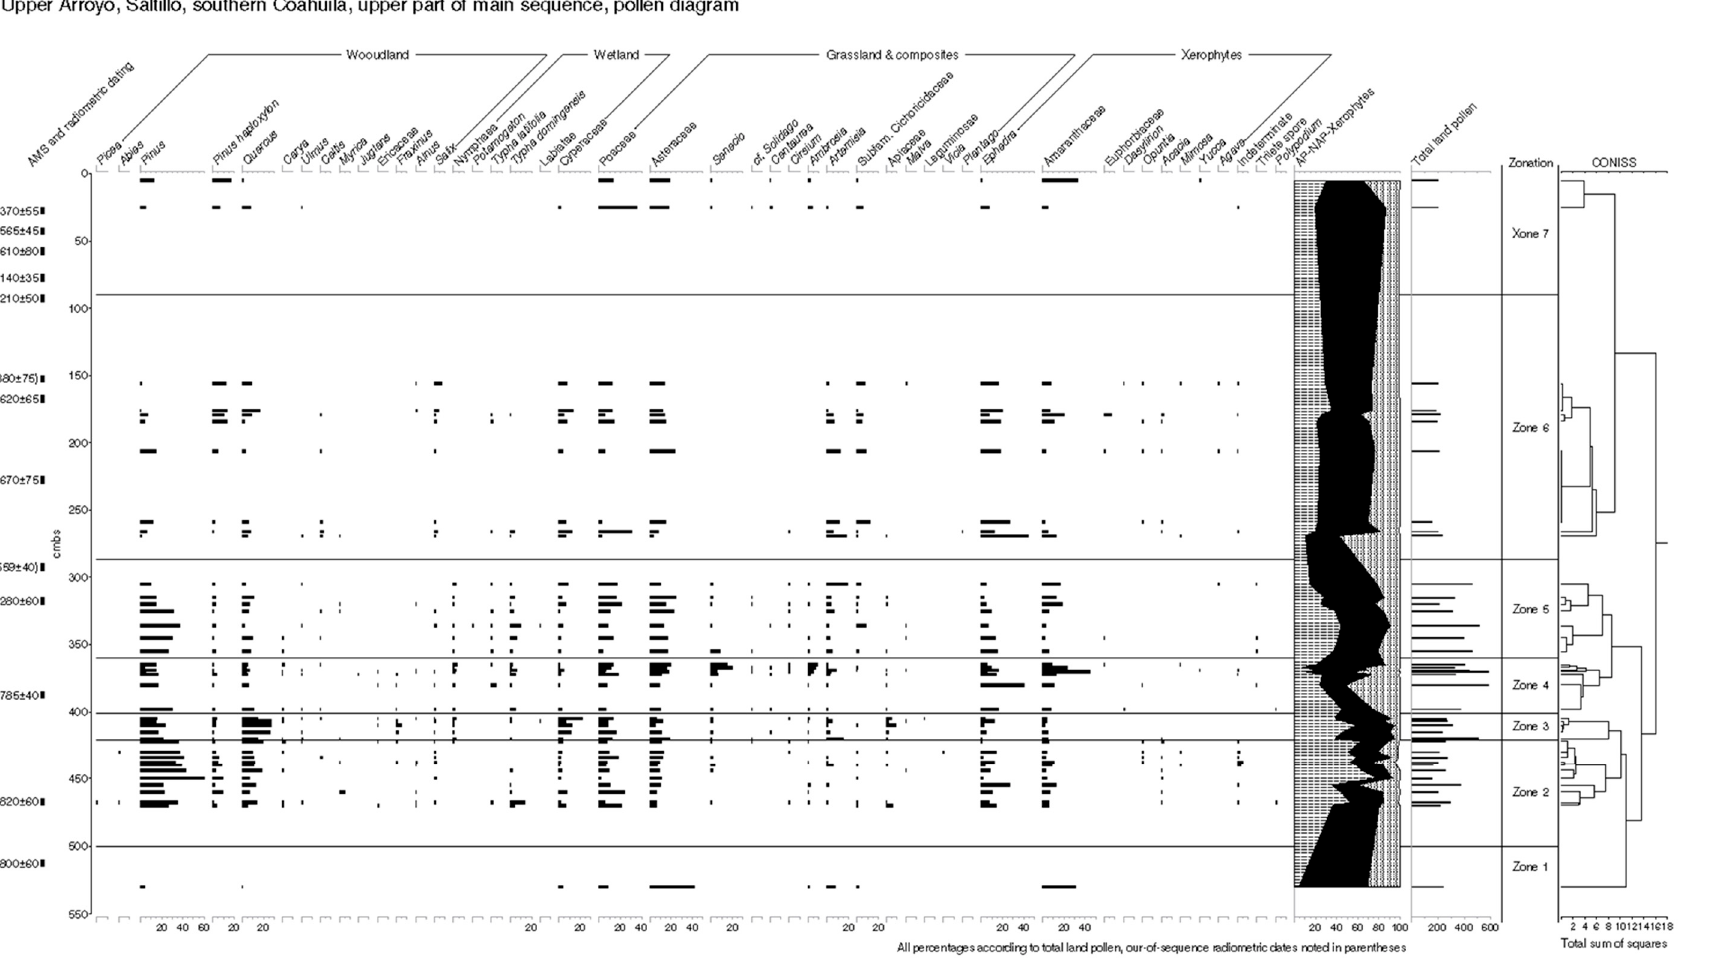
Figure 11. Relative pollen diagram of the Upper Arroyo main sequence, upper part.